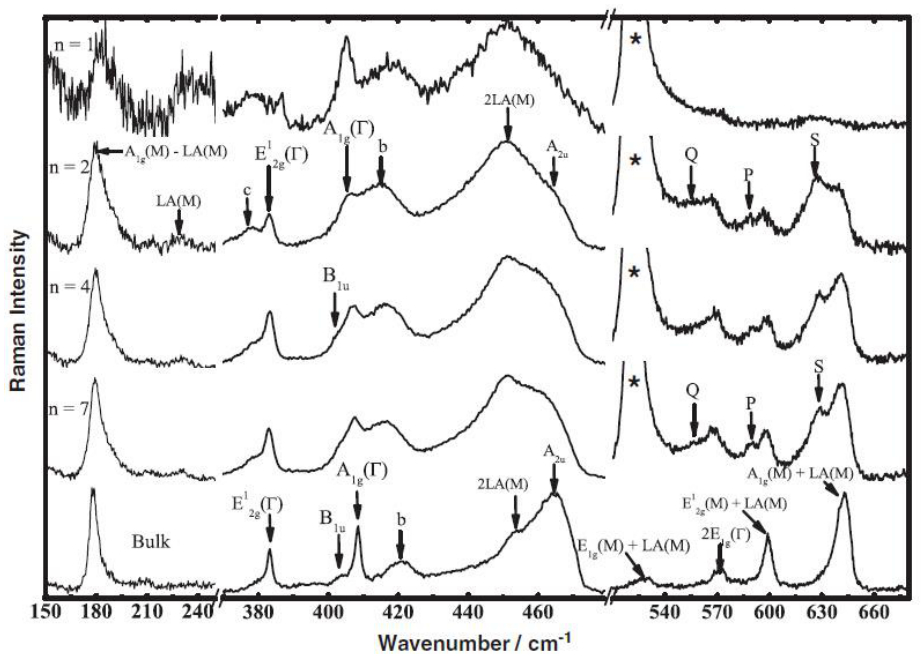
Figure 8. Resonant Raman spectra of different thickness MoS 2 using 632.8 nm laser in room temperature [93]. Reprinted figure with permission from [Chakraborty, B.; Matte, H.S.S.R.; Sood, A.K.; Rao, C.N.R. Layer-dependent resonant Raman scattering of a few layer MoS 2 . J. Raman Spectrosc. 2013 , 44 , 92–96.] Copyright (2013) by John Wiley and